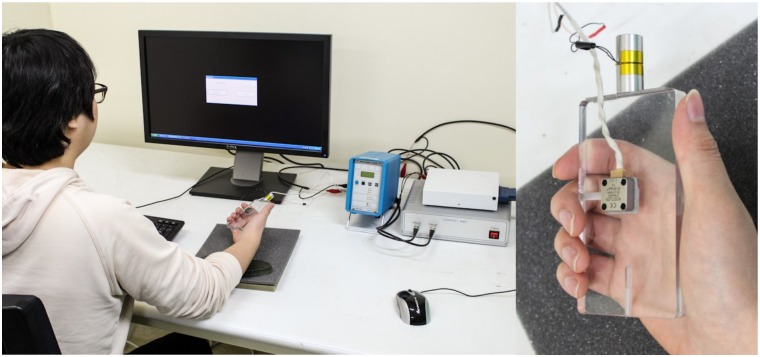
Experimental setup and posture of the participant.